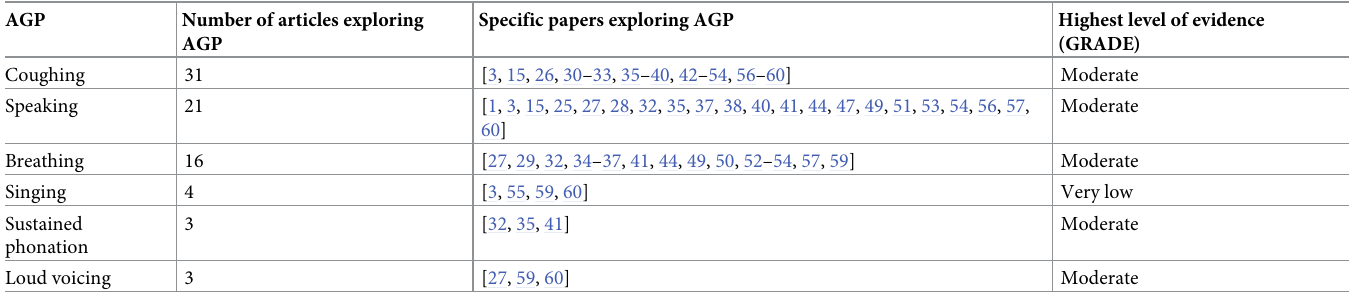
Table 2. Types of AGPs identified.